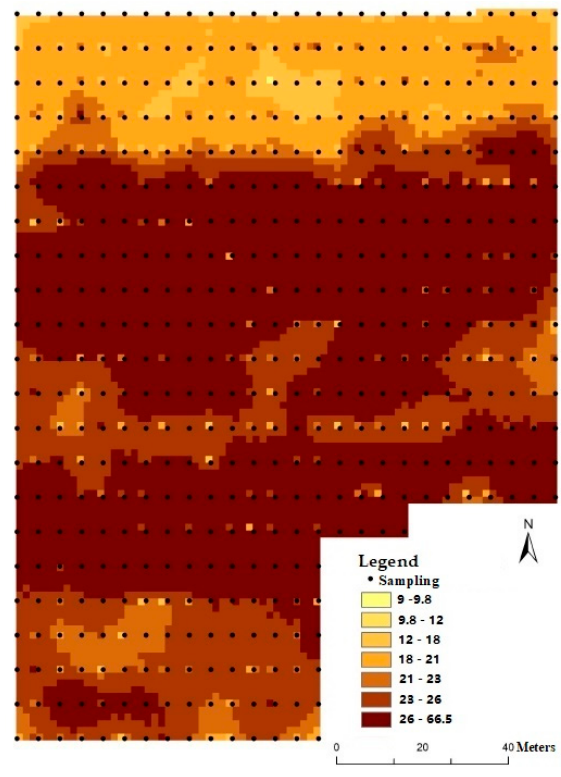
Figure 10. Grid map of VMC from 500 SGSs in the harvest stage.